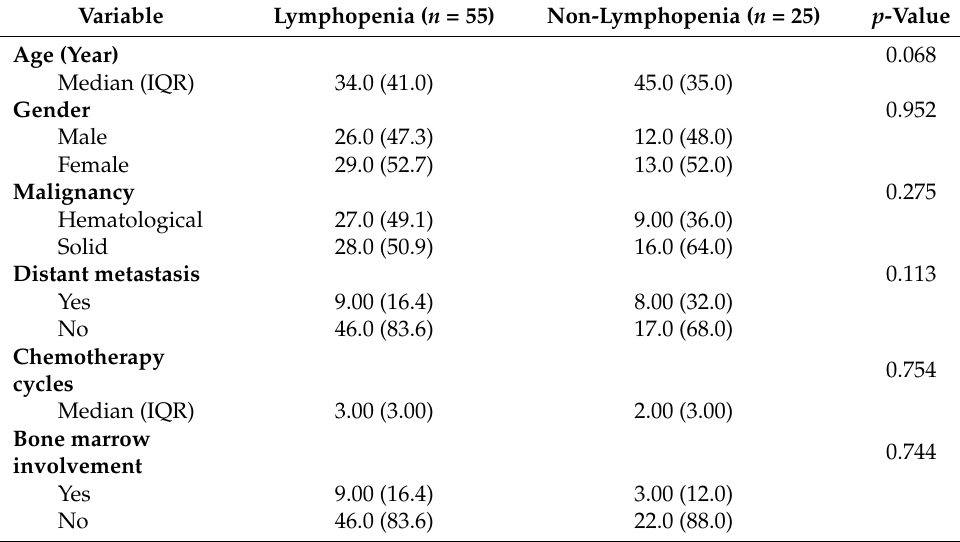
Table 1. Demographics and disease characteristics of a cohort of patients with chemotherapy-induced febrile neutropenia treated with G-CSF and subdivided according to the absolute lymphocyte count at admission with a cutoff point of 700lymphocytes/ µ L − 1